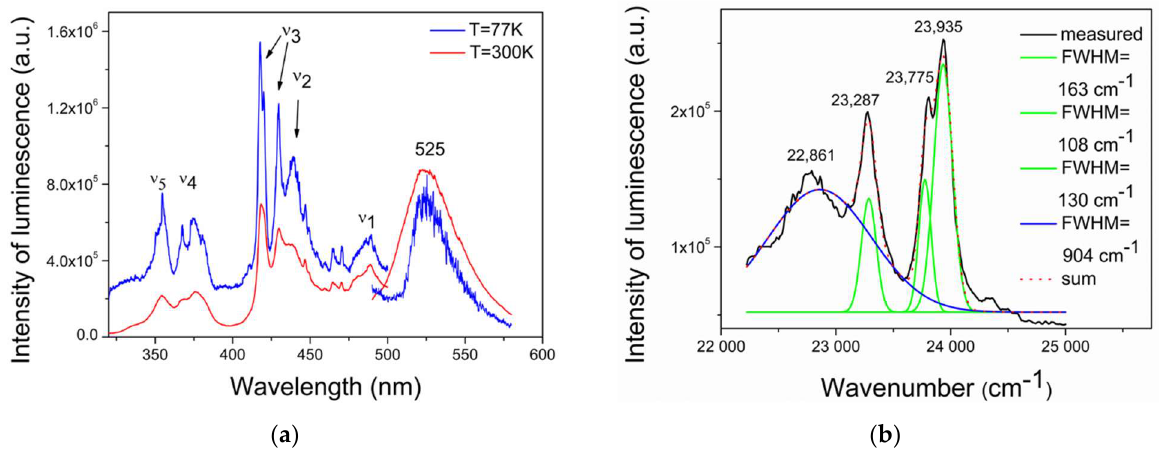
Figure 11. Luminescence spectra of willemite W1 sample: ( a ) emission and excitation of Mn 2+ measured at T = 300 K and T = 77 K; ( b ) deconvolution of υ 2 and υ 3 bands.